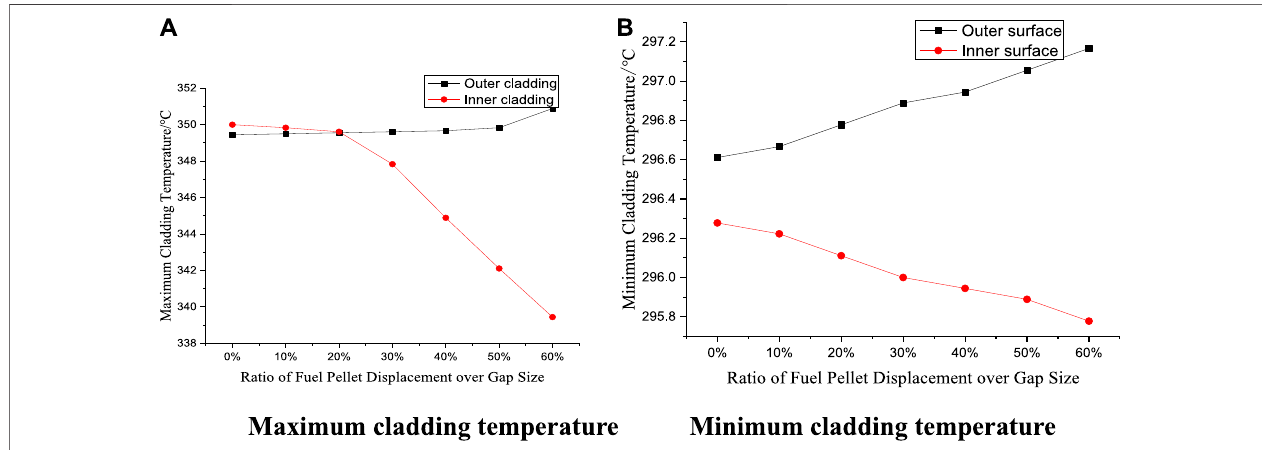
FIGURE 14 | Maximum and minimum cladding temperature of inner and outer channel fuel pellet displacement variation.